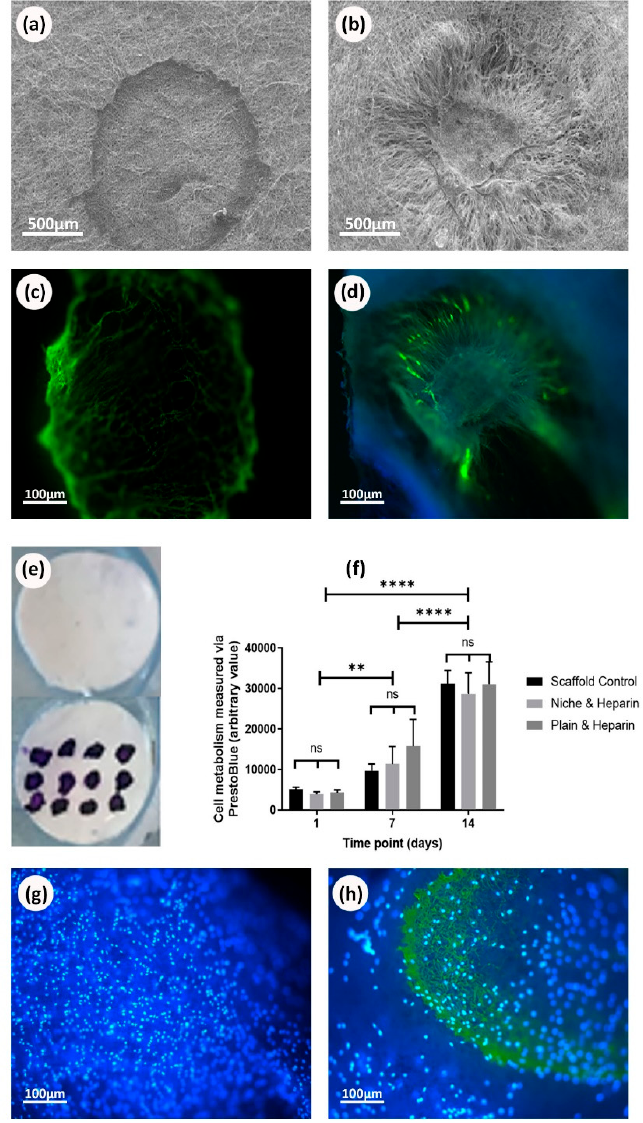
Figure 7. Deposition of heparin onto electrospun sca ff olds and 14 day culture with rMSCs: ( a ) SEM image of plain sca ff olds with heparin deposited on the surface; ( b ) SEM image of heparin deposited into niches; ( c ) fluorescent image of fluorescent heparin (green) deposited onto electrospun sca ff olds without niches; ( d ) fluorescent image of fluorescent heparin (green) deposited onto electrospun sca ff old with niches; ( e ) toluidine Blue staining for plain heparin coated sca ff olds and control; ( f ) cell metabolic data from PrestoBlue ® assay based on a 14 day culture of rMSC cells on electrospun sca ff olds with and without niches and heparin. No statistical difference is found between any of the conditions, ANOVA test used, bars are the mean ± SD (N = 1, n = 3); ( g ) fluorescent image of nuclei DAPI staining (blue) 14 days culture of rMSC cells on plain scaffold without heparin; ( h ) fluorescent image of nuclei DAPI staining (blue) and fluorescent heparin (green) from 14 days culture of rMSC cells on plain scaffold.